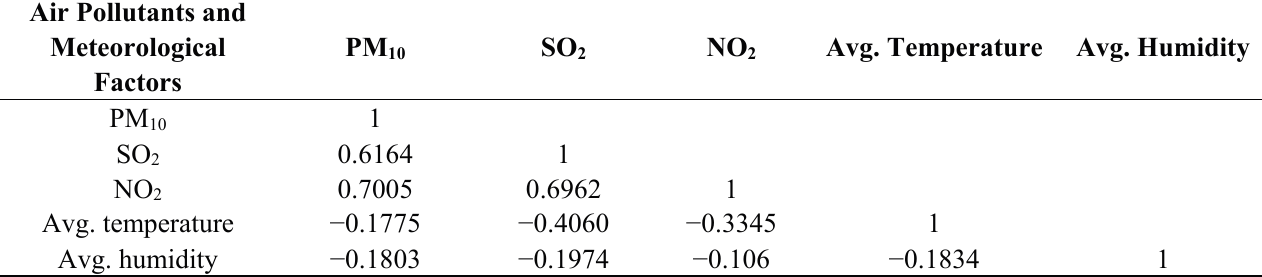
Table 3. Spearman rank correlation coefficient analysis of meteorological factors and daily concentrations of air pollutants in Wuhan,